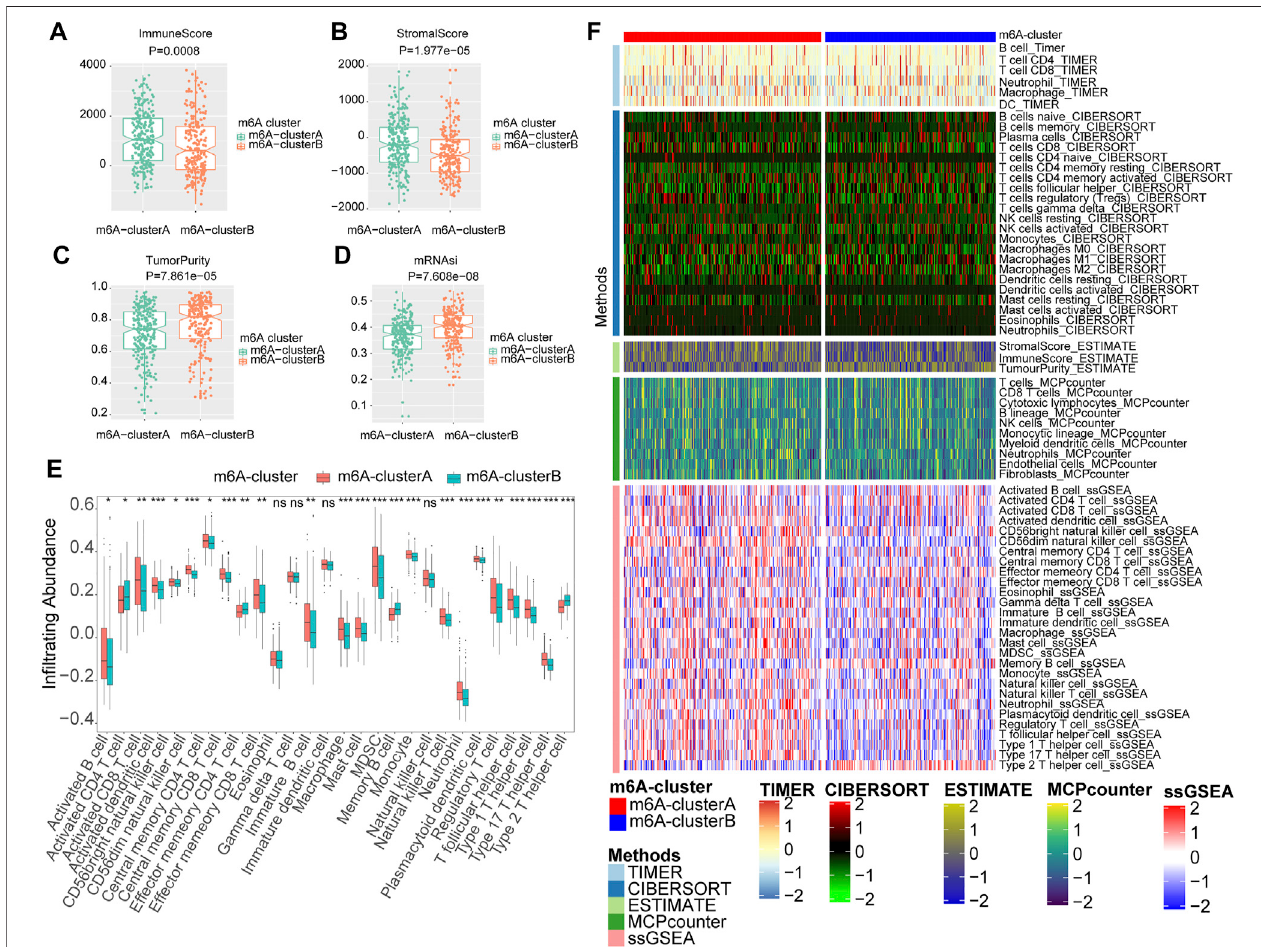
FIGURE 5 | The two m6A clusters show differential immune in fi ltration. (A) Immune scores in melanoma samples were compared between the two m6A clusters. (B) Stromal scores in melanoma samples were compared between the two m6A clusters. (C) Tumor purity in melanoma samples was compared between the two m6A clusters. (D) MRNAsiinmelanoma samples werecomparedbetweenthe two m6Aclusters. (E) In fi ltrating abundances of28immunecells were compared between the two m6A clusters (Wilcoxon test, * p < 0.05, ** p < 0.01, *** p < 0.001) (F) The landscape of immune in fi ltration based on TIMER, CIBERSORT, estimate, MCP counter, and ssGSEA